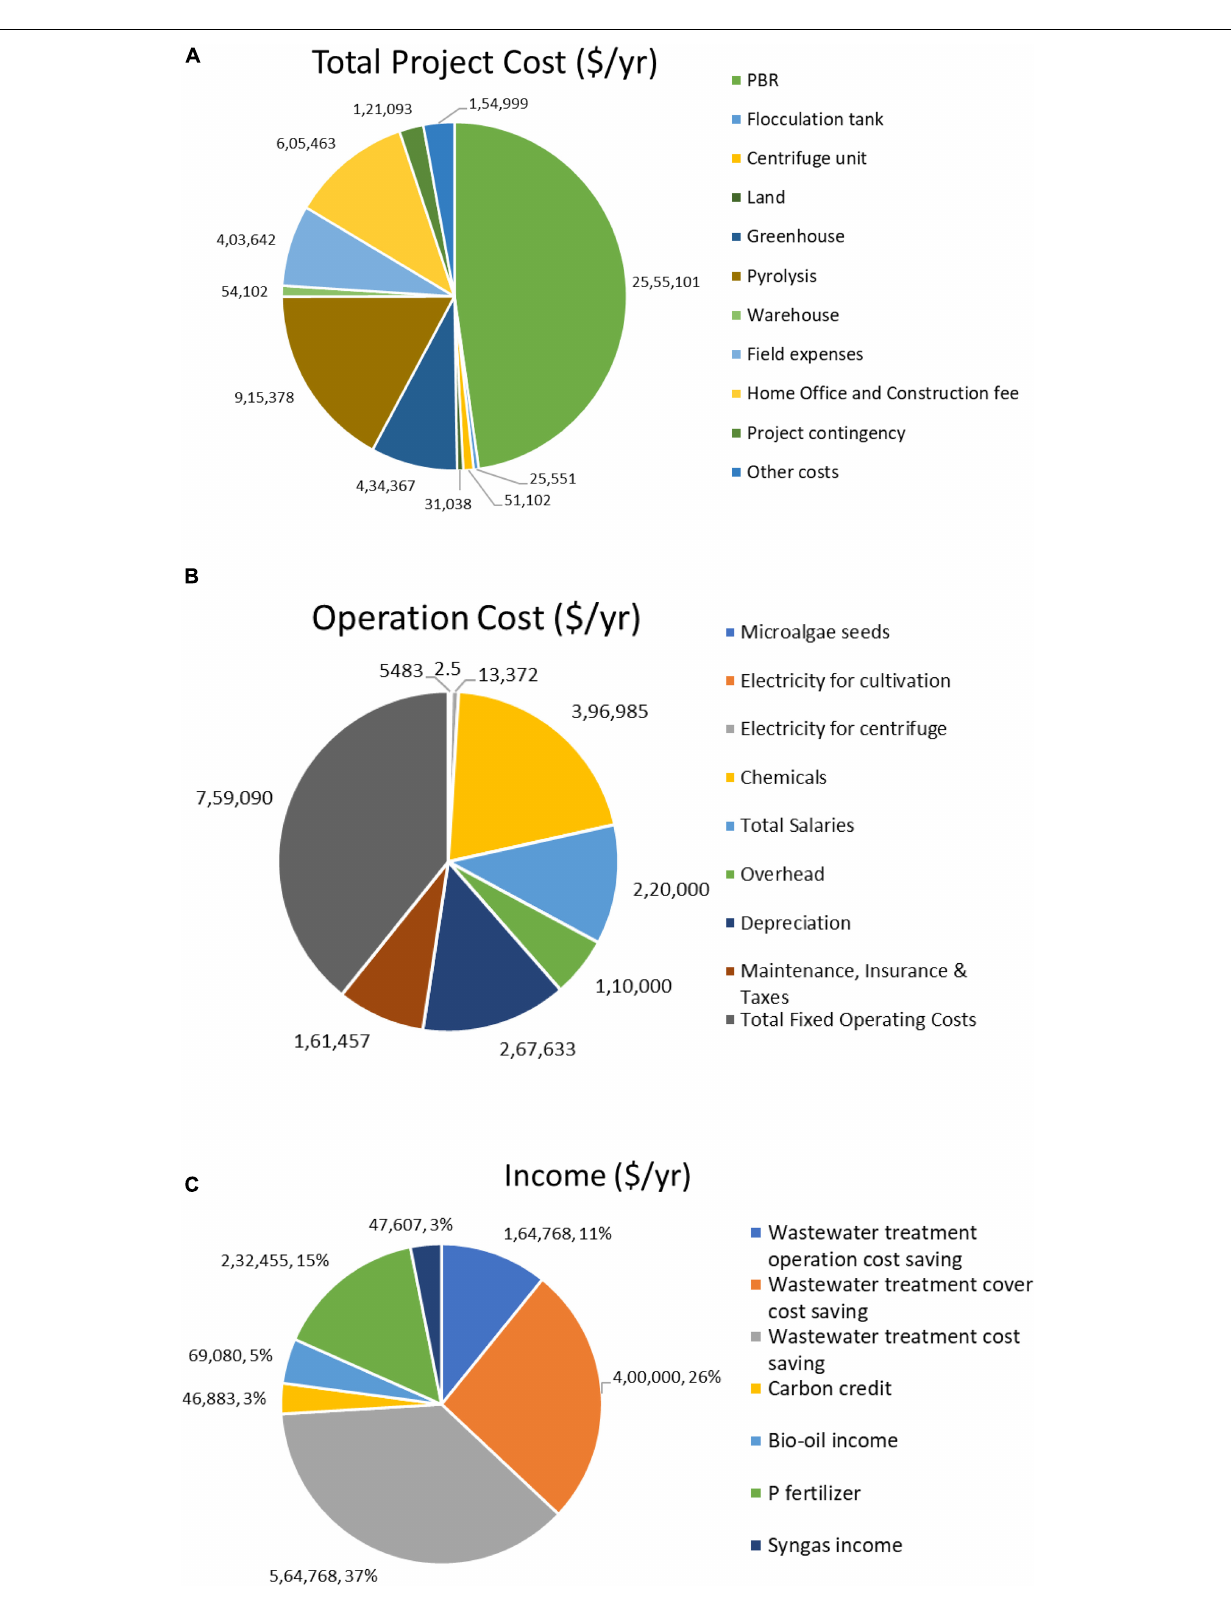
Frontiers in Energy Research |